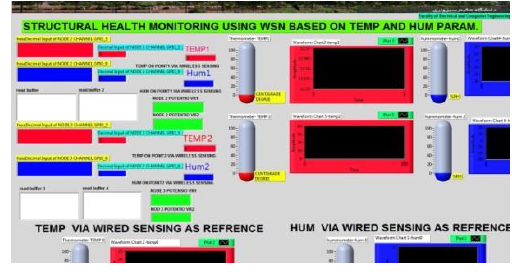
Figure 7. Front panel of